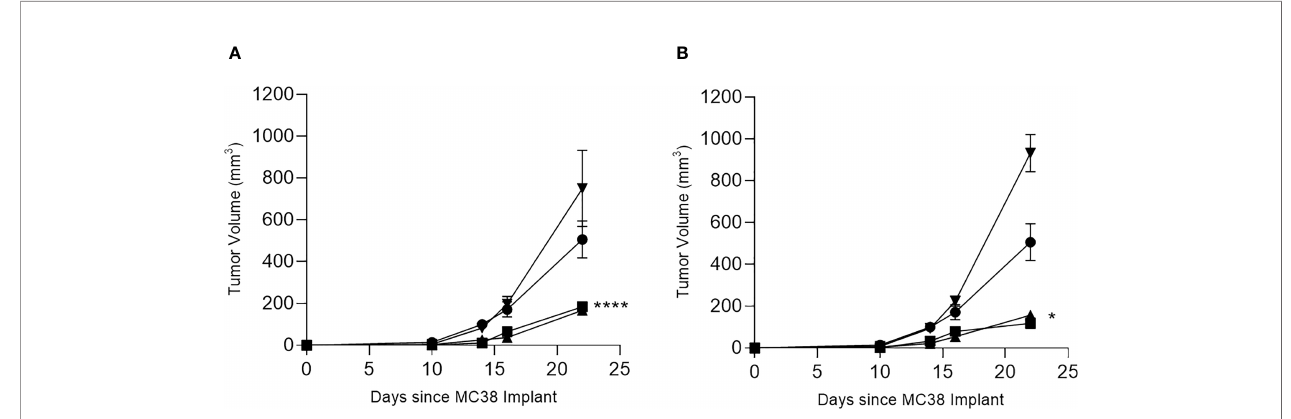
FIGURE 4 | The anti-tumor ef fi cacy of vaccination is dependent on CD8 + T cells. Mean ( ± SEM) tumor volume (mm 3 ) from mice immunized with PBS ( ● ) or with (A) CDC25B peptides or (B) COX2 peptides and treated with control IgG ( ▪ ), anti-CD8 ( ▼ ) or anti-CD4 ( ▲ ). *p < 0.05, ****p < 0.0001; n = 5